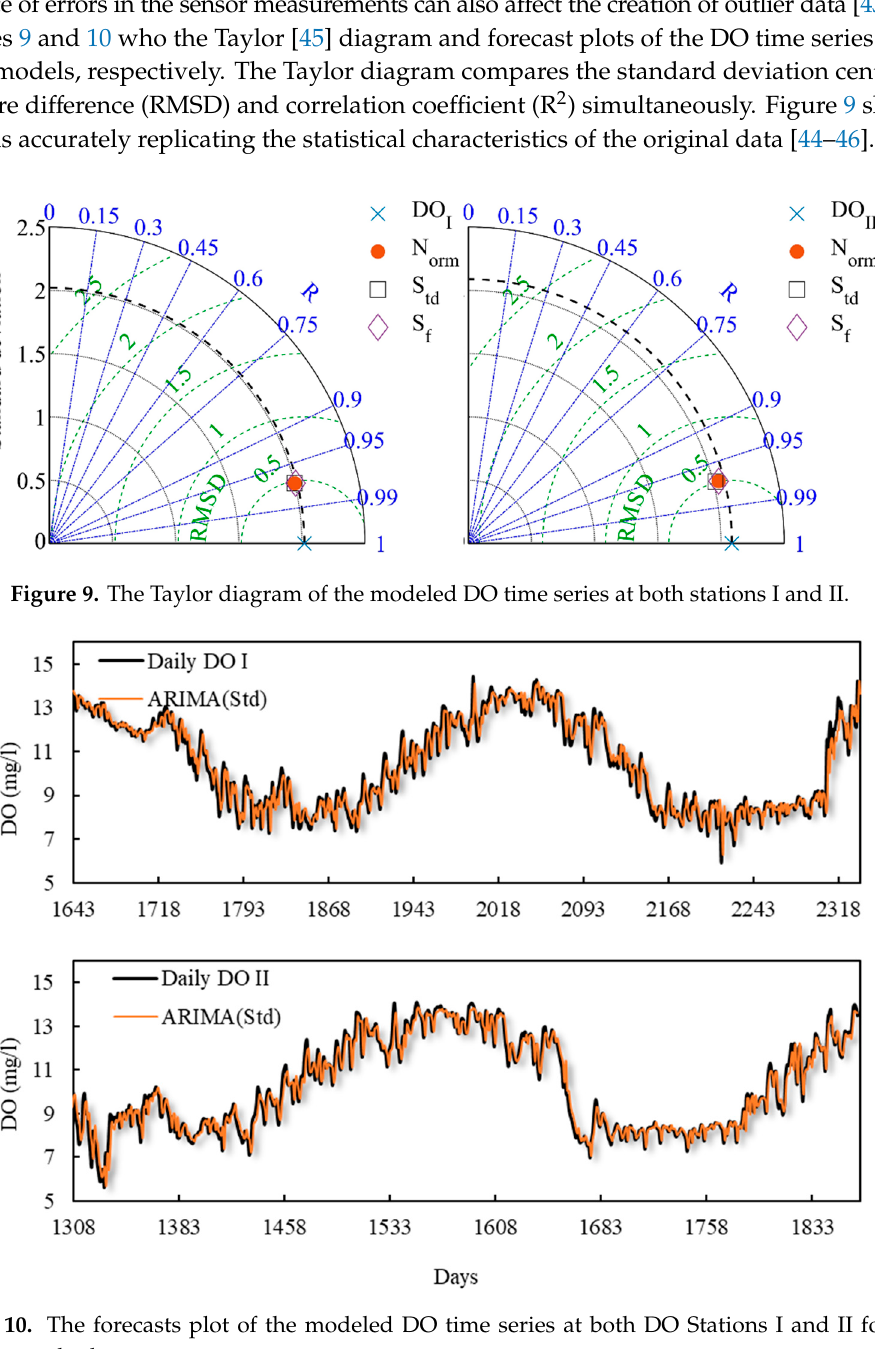
Figure 10. The forecasts plot of the modeled DO time series at both DO Stations I and II for the superior method.